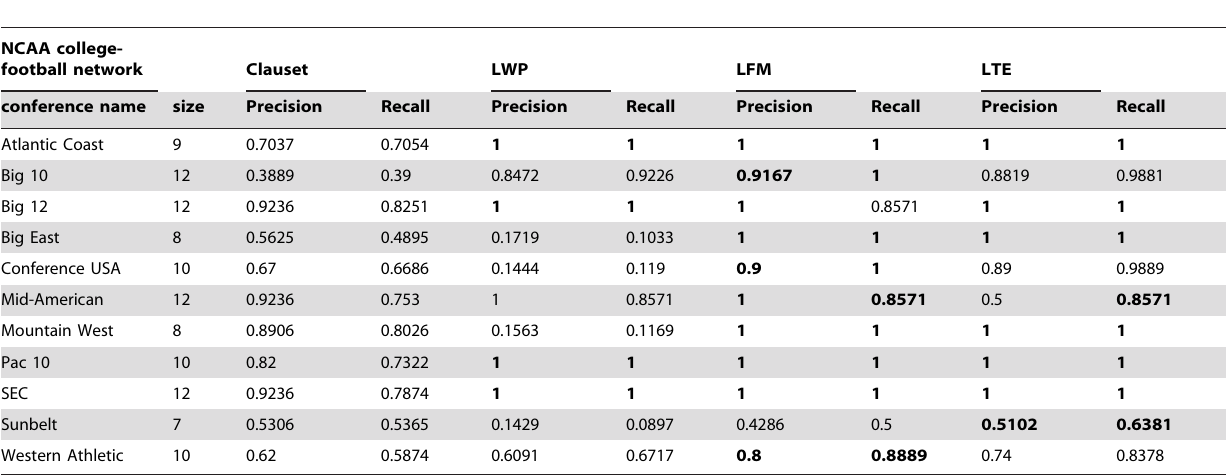
Table 1. Accuracy comparison of local community detection methods for each conference in NCAA college-football